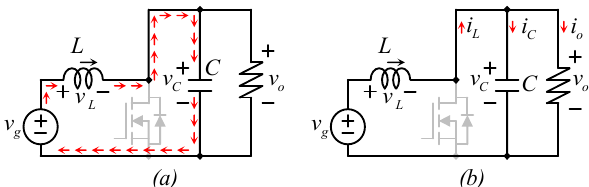
Figure 3. Equivalent circuit state when s 1 = 0 showing ( a ) the voltage loop of the inductor, ( b ) the current node in the capacitor.